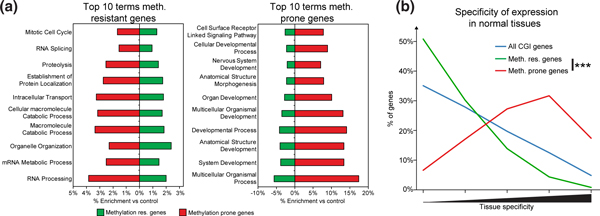
Genes prone to hypermethylation in cancer are not constitutively expressed. (a) Hypermethylation-prone and -resistant genes are associated with distinct biological processes. Shown are graphs of the percent enrichment or depletion for the 10 most enriched GO biological process in the hypermethylation resistant and prone gene sets. For each term the enrichment or depletion in both gene sets is plotted. All terms were enriched or depleted to a significant level for both gene sets (Fisher's exact tests, P < 0.05). (b) Hypermethylation prone genes are tissue-specific. Histograms show the distribution of tissue-specificity scores observed for hypermethylation prone and resistant genes. Specificity scores for prone and resistant gene sets were compared using a Wilcoxon rank sum test. (*** P < 0.001). GO, genome ontology.